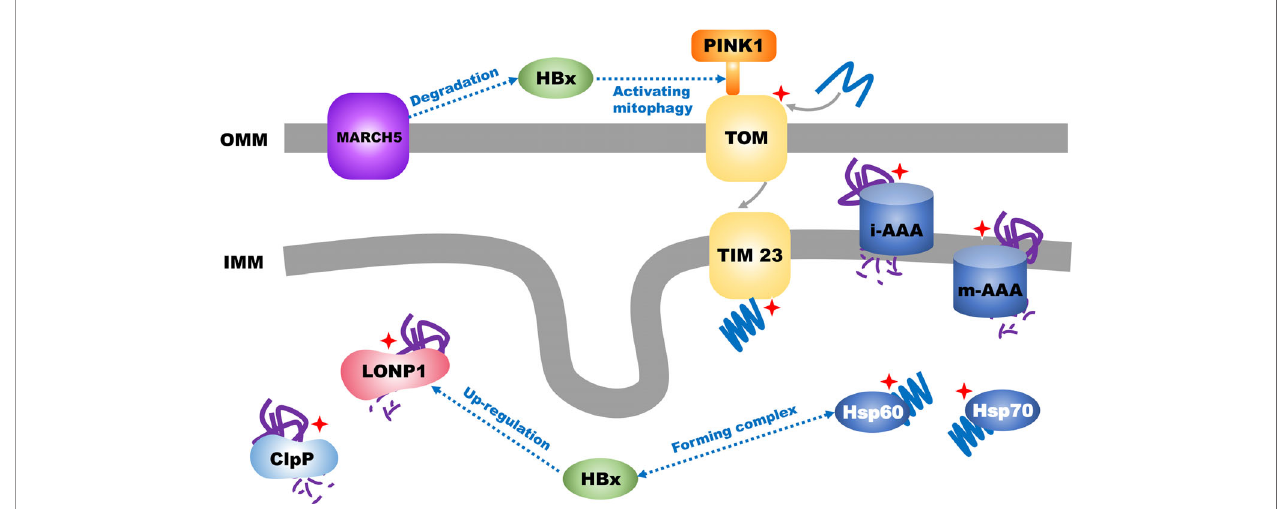
FIGURE 2 | Transport of mitochondrial proteins and mitochondrial unfolded protein response in HCC. Mitochondrial unfolded protein response is labelled with red